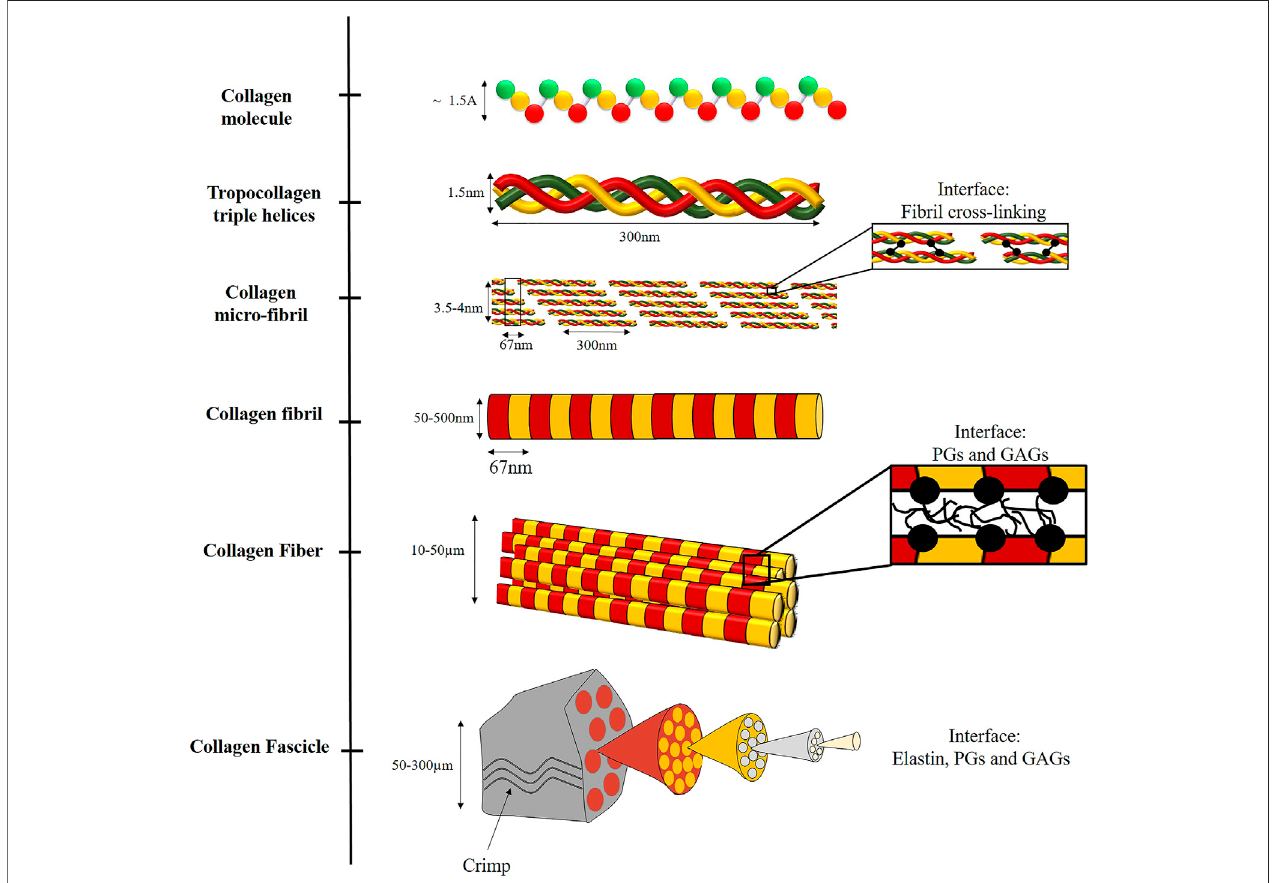
FIGURE 2 | Illustration of the hierarchical structure of collagenous fi brous tissues, including the different interfaces. At the nano-scale, collagen is assembled from three left-handed alpha-helices stabilized by hydrogen bonds and covalent cross-links to form a triple helix (tropocollagen). Tropocollagens are staggered into a larger array with a repeated D-period to form fi brils, via covalent cross-linking. The fi brils are assembled to fi bers, bound by weak interactions with PGs and GAGs. The fi bers are assembled to fascicles. In this level, elastin, PGs and GAGs are also present. Crimping also occurs at this structural level.